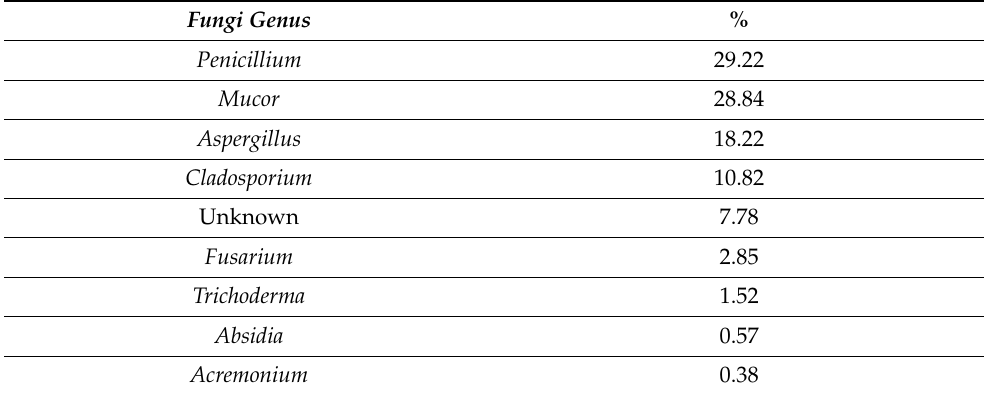
Table 2. Diversity of the isolated fungal strains present on the Escoural Cave.